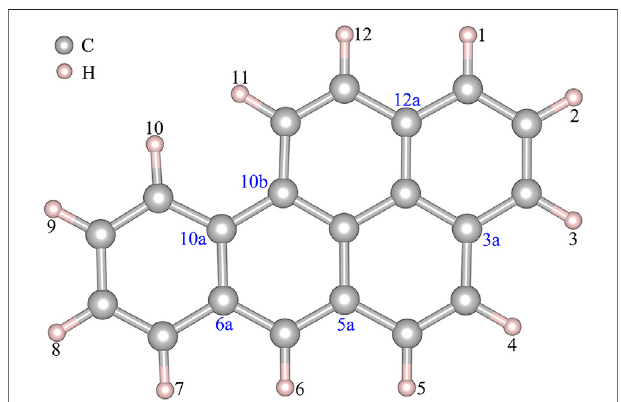
FIGURE 1 | Partial atomic numbers of BaP.